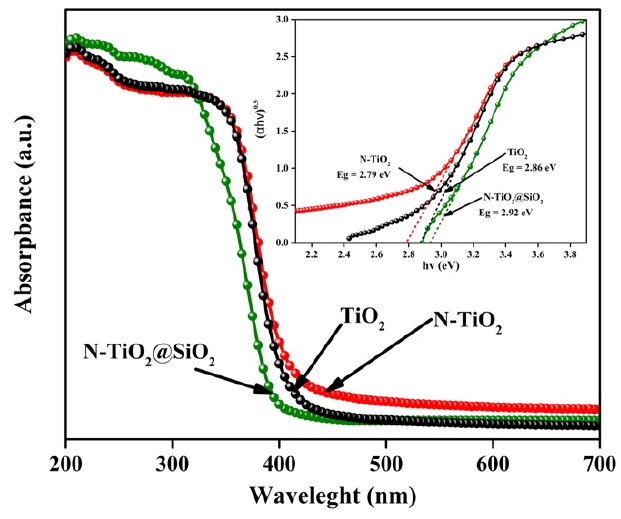
Figure 5. UV-Vis Near-Infrared spectrum and band gap energy calculated by Tauc plot (inset) of TiO 2 , N-TiO 2, and core/shell N-TiO 2 @SiO 2.